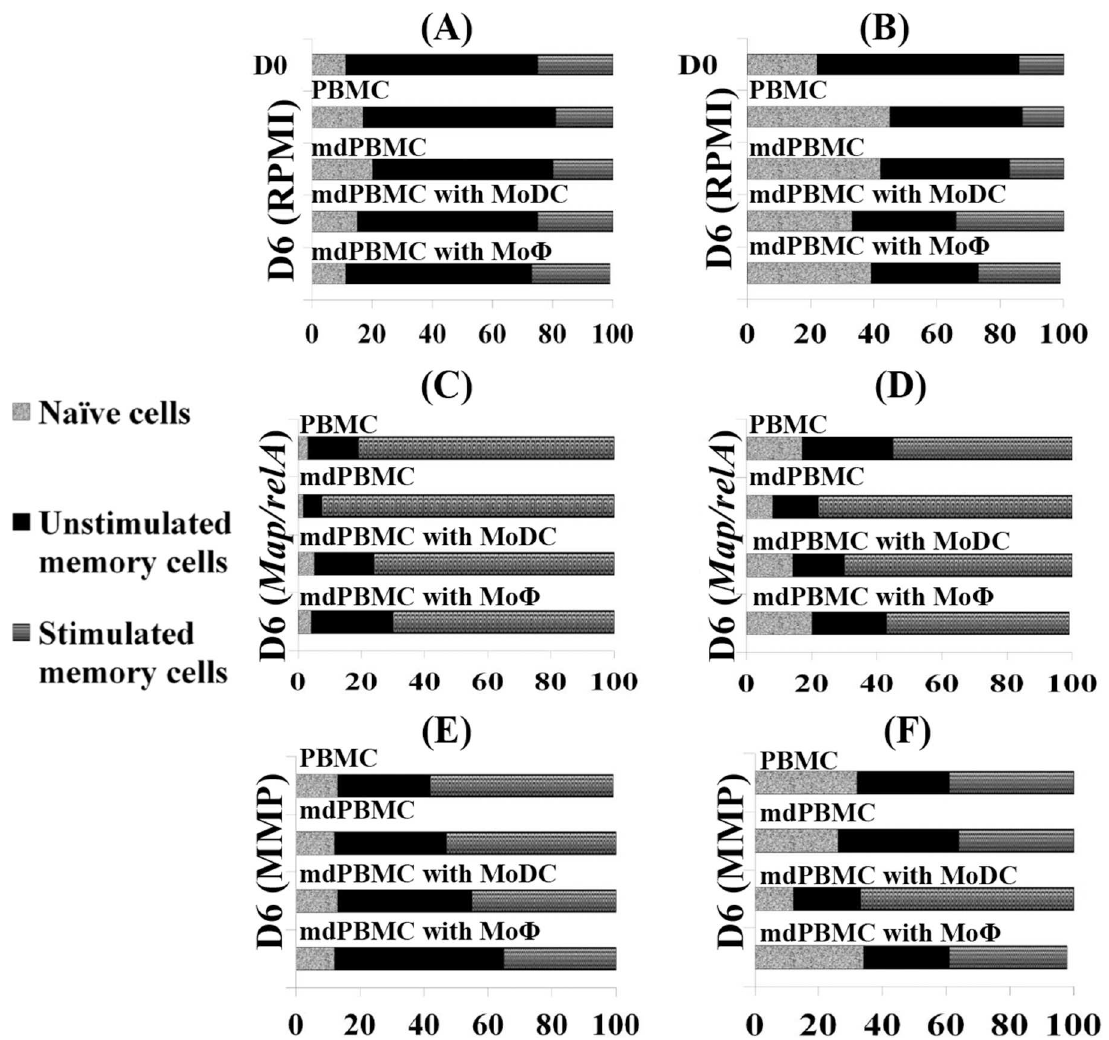
Fig 4. Comparison of the CD4 and CD8 recall responses to Map/relA and MMP. A, Bar graphs of FC data comparing CD4 T cell responses in whole PBMC at T0 and followingculture for 6 days in RPMI alone and mdPBMC cultured in RPMI alone or in the presence of MoDC and MoM Φ not exposed to Ags. C. Bar graphs comparingCD4 T cell responsesin wholePBMC and in mdPBMC stimulated directly with Map/relA for 6 days and in mdPBMC cultured for 6 days with MoDC and MoM Φ pulsed with Map/relA . E. The same culture conditionswith CD4 T cells cultured with MMP directly or with MoDC and MoM Φ pulsed with MMP. B , D , F . Bar graphs of FC data comparingCD8 T cells cultured under the same conditionsas CD4 T cells. As noted, na ï ve, resting memory, and activated memory CD4 and CD8 T cells are distinguished by different shades of grey. Comparisons show there was a clear increase in the proportion of activated memory CD4 and CD8 T cells in cultures stimulated directly with Map/rel/A and MMP or through MoDC and MoM Φ pulsed with the Ags. See Fig 1 for gating strategy used to distinguish na ï ve, resting and activated memory T